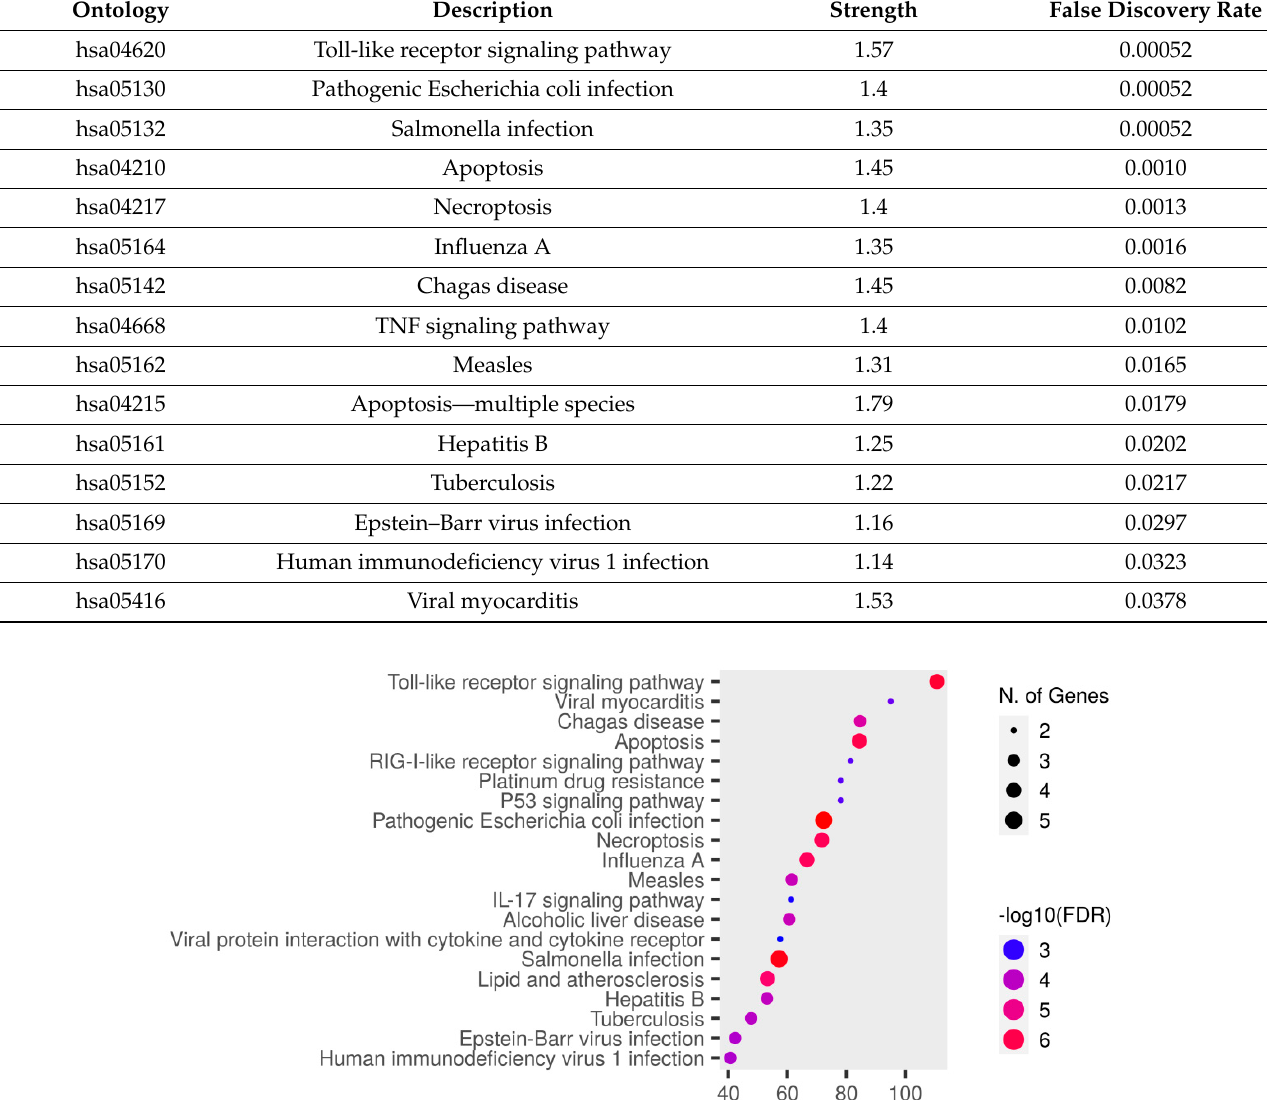
Table 4. Enriched KEGG pathways for miRNA-146a and miRNA-126 validated targets.